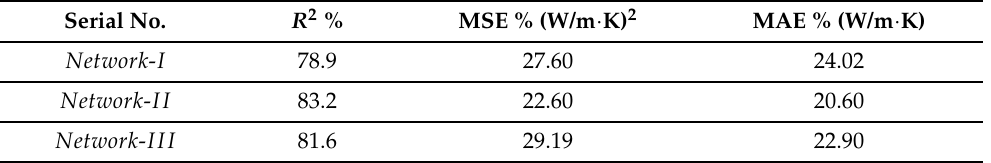
Table 4. The errors resulting from different GMDH